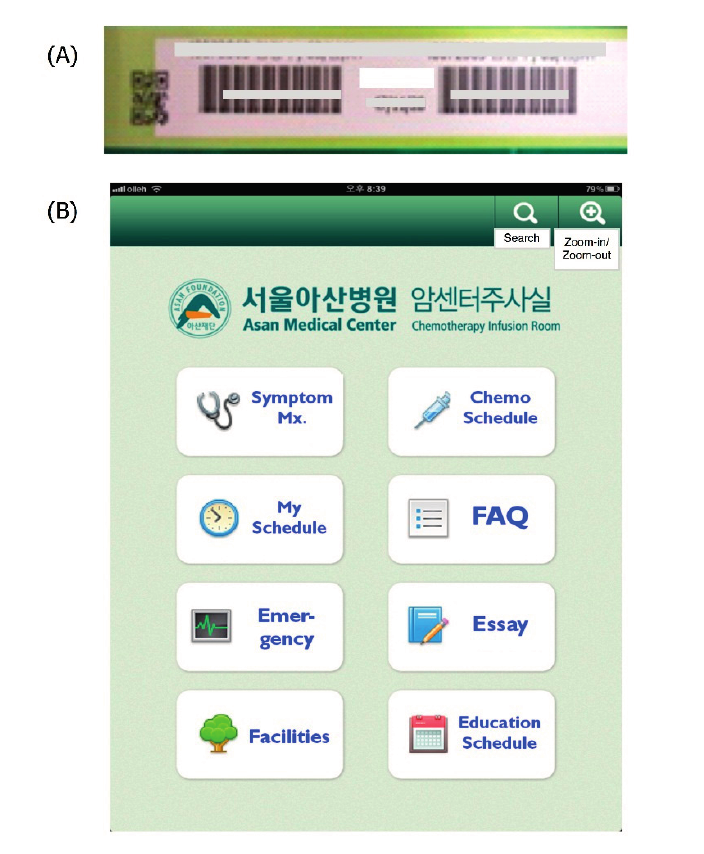
Figure 1. My Cancer Diary application ( A ) Patient barcode sample ( B ) Screenshot of main